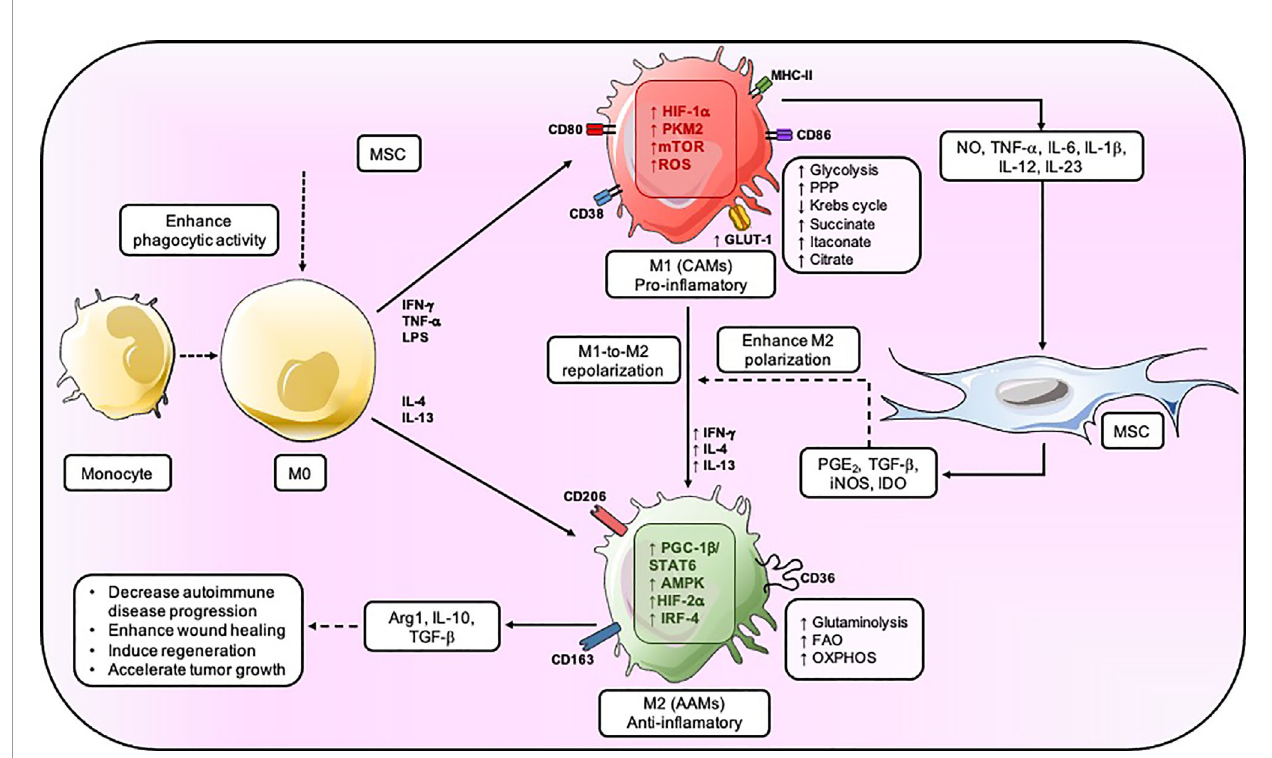
FIGURE 2 | MSC regulates the metabolic fate of macrophage. MSC enhances the phagocytic activity of M0, but the in fl ammation generated by the M1 results in an increase in glycolysis, PPP, and a decrease in Krebs ’ s cycle. MSC provokes PGE 2 , TGF- b , INOS, and IDO to induce M2-like macrophage that mainly have an OXPHOS metabolic status and secrete IL-10, Arg1, and TGF – b which will reduce autoimmune disease progression, enhance wound healing, and accelerate tumor growth. CAMs, classically activated macrophage; AAM. alternatively activated